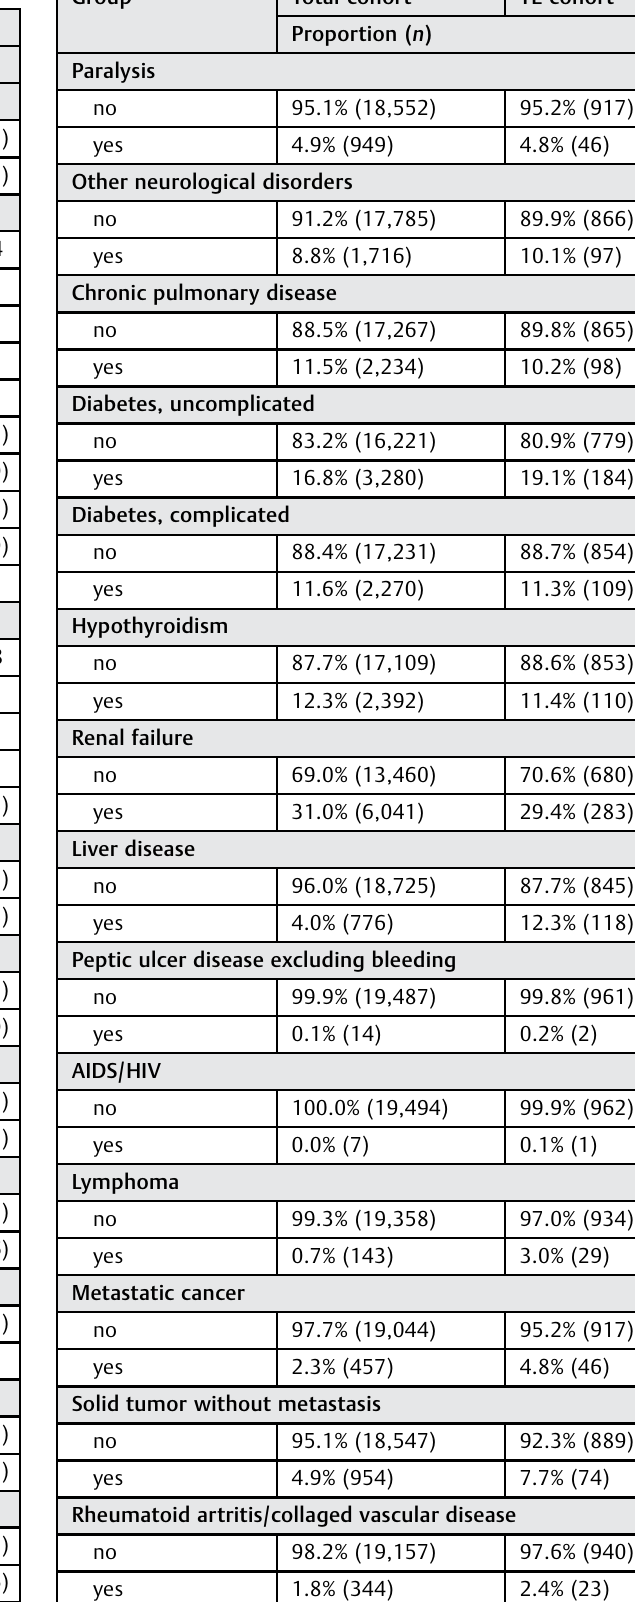
Table 1 Patient characteristics of the total cohort and the subcohort of patients with thromboembolic events